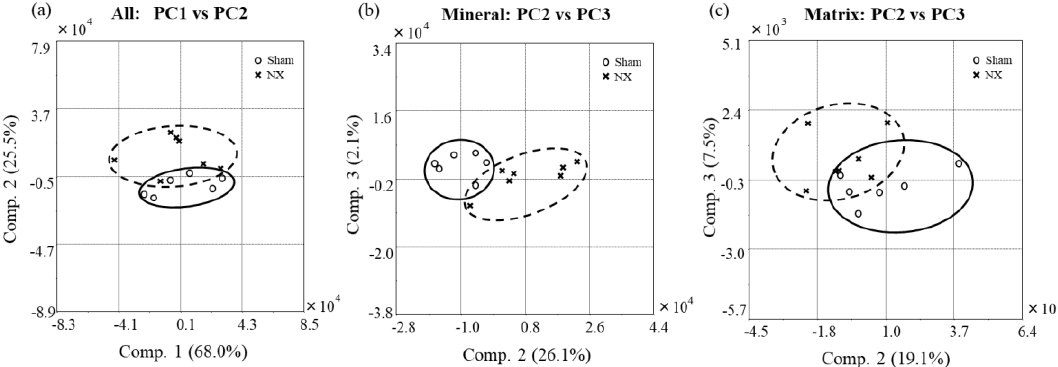
Figure 3. Score plots of the Principal Component Analysis (PCA) analysis of Raman spectra. The X and Y axes include any principal components (PCs) that differed between the NX and Sham groups, with the distance on the axis indicating the degree of difference. PCA plots were built with ( a ) all spectral regions, ( b ) a partially extracted spectral region for the mineral component, and ( c ) a partially extracted spectral region for the matrix component.